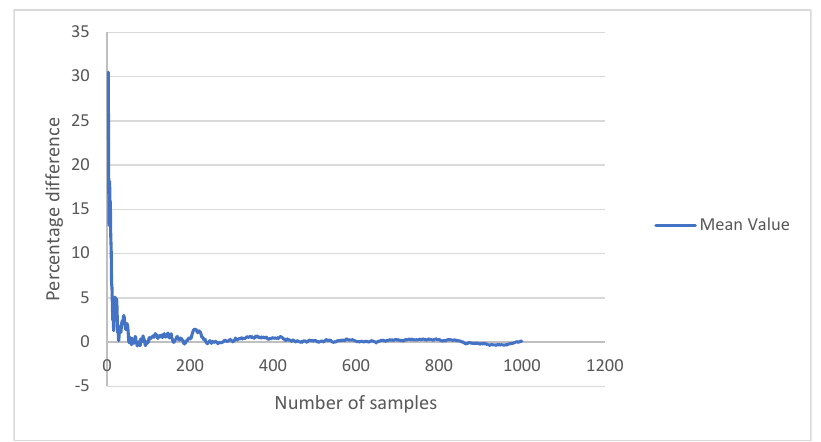
Figure 5. Convergence of the mean value of a randomly selected Monte Carlo simulation for the output failure load. In the horizontal axis, the number of samples; and in the vertical axis, the percentage difference of the mean value in relation to the statistical moment in the 100 samples.